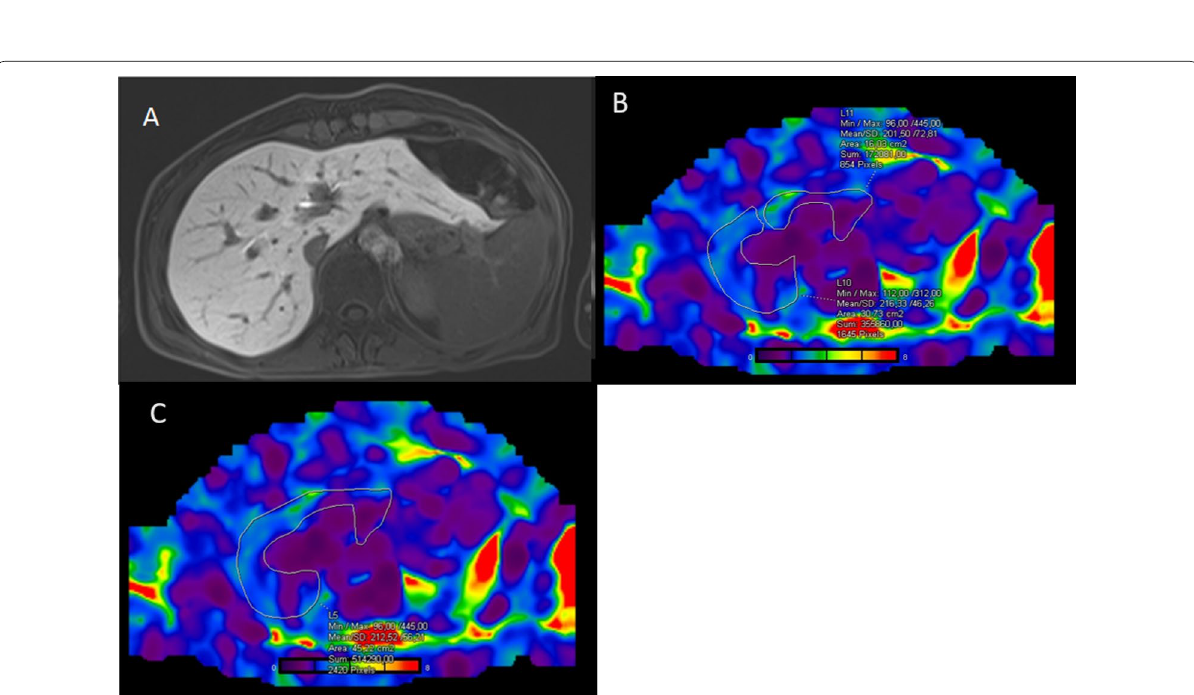
Fig. 3 Hepatobiliary phase image in the control group case ( A ). Right lobe MRE-LSM is 2.16 kPa, left lobe MRE-LSM is 2 kPa ( B ). Total MRE-LSM is 2.12 kPa ( C